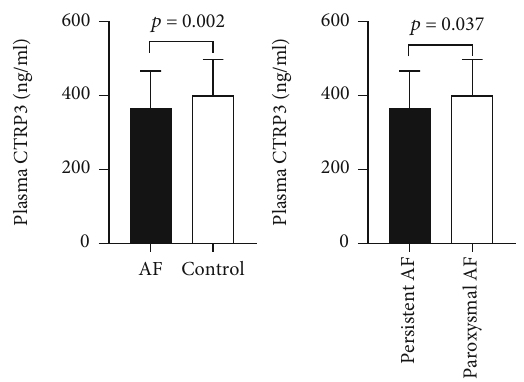
Figure 1: Comparison of plasma CTRP3 concentrations between patients with sinus rhythm and AF patients and between the